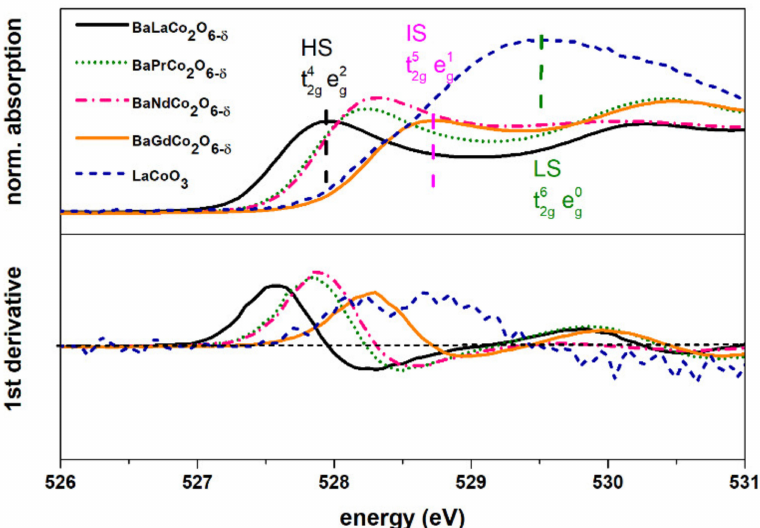
Figure 9. ( a ) X-ray Absorption Spectroscopy (XAS) spectrum of Co L 2,3 and Ba M 4,5 edges. ( b ) XANES (X-ray Absorption Near Edge Structure) spectra of Co L 3 -edge for studied materials and reference sample (CoO).